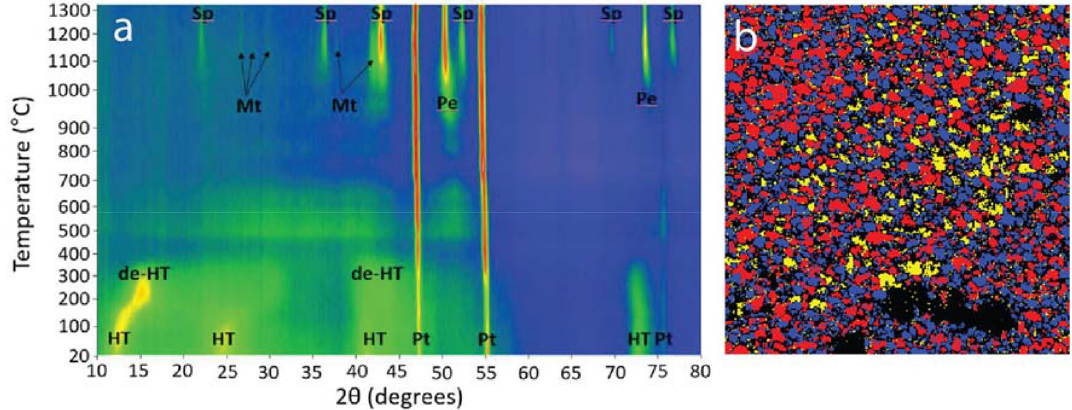
Figure 2. ( a ) Evolution of X-Ray diffraction signal during amorphization and subsequent phase transformation of hydrotalcite as a function of temperature (20–1320 °C). HT hydrotalcite, de-HT dehydrated hydrotalcite, Pe périclase, Sp spinel, Mt monticellite. Pt represents the platinum heating strip within the experimental cell. ( b ) EBSD phase map confirming the mineralogy as determined in ( a ) and showing the distribution and textural relationships among spinel (red), periclase (blue) and monticellite (yellow).